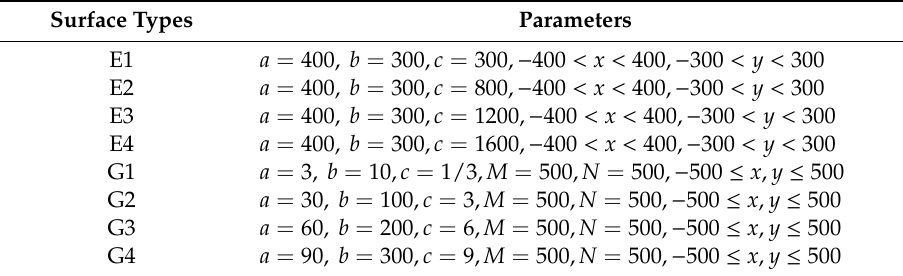
Table 1. Parameters of the eight mathematical surface models.